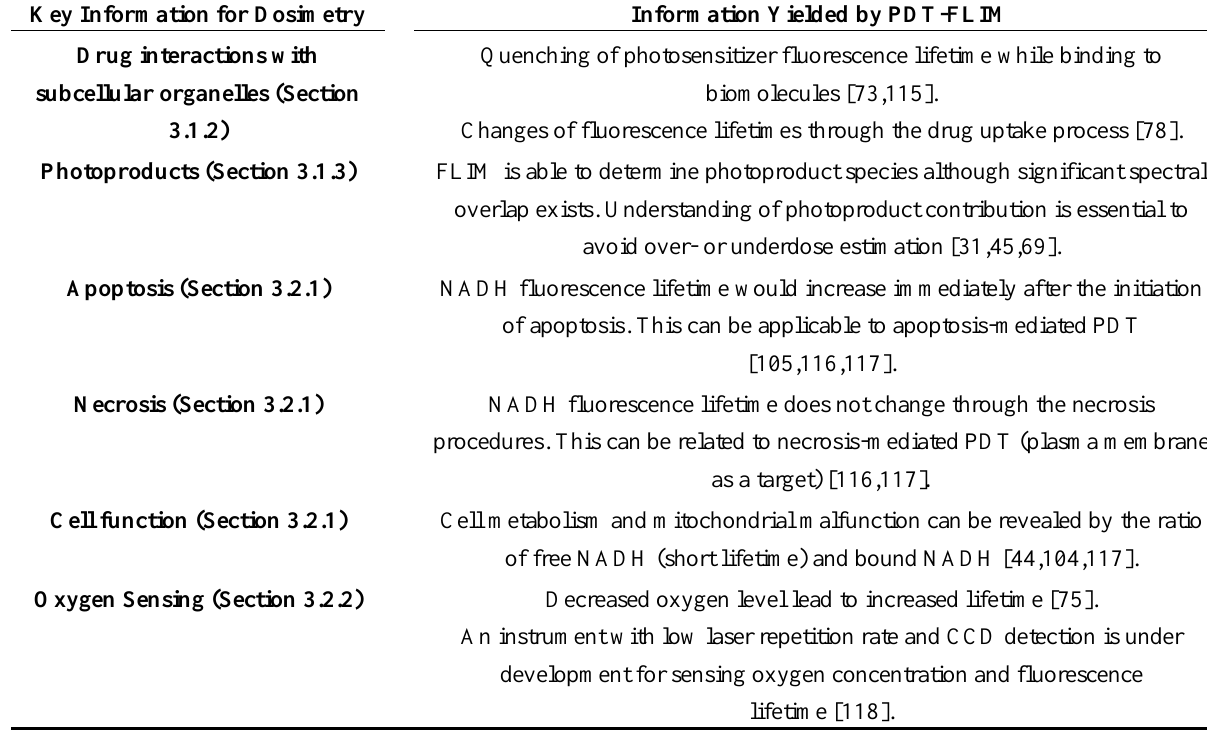
Table 5. Implications from